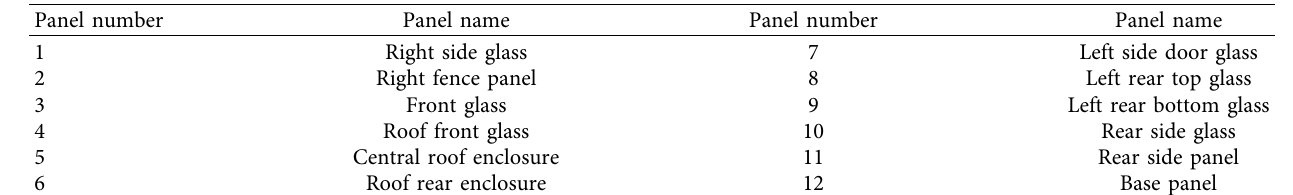
Figure 9: Simulation and experimental SPL curve. Table 1: Cab panel division.